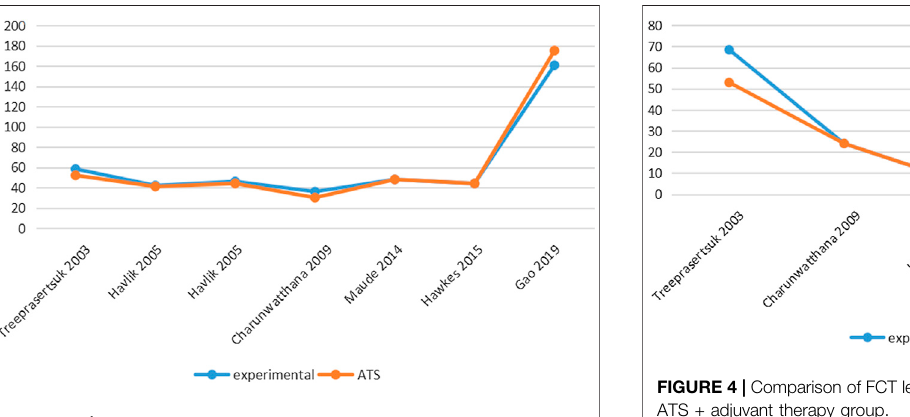
FIGURE 3 | Comparison of PCT levels in ATS monotherapy group and ATS + adjuvant therapy group.